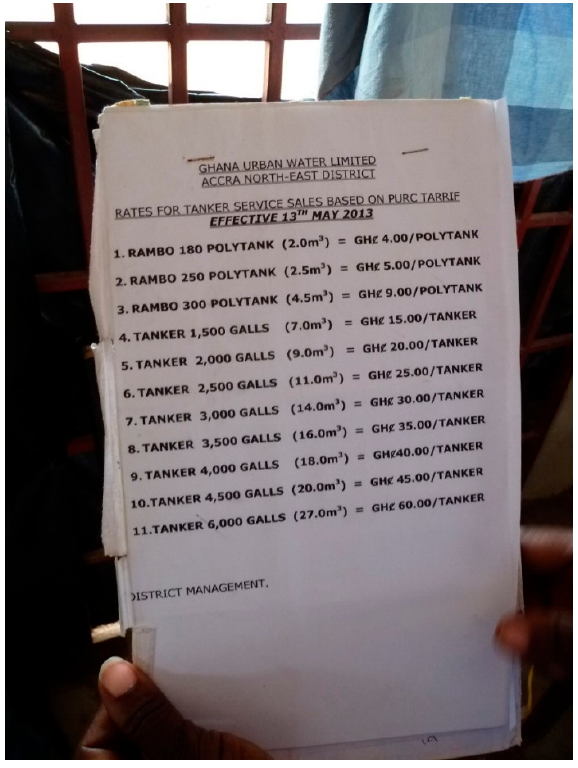
Figure 3. Water tariffs for tankers at one of the overhead hydrants managed by the GWCL. Source: Authors, October 2015.